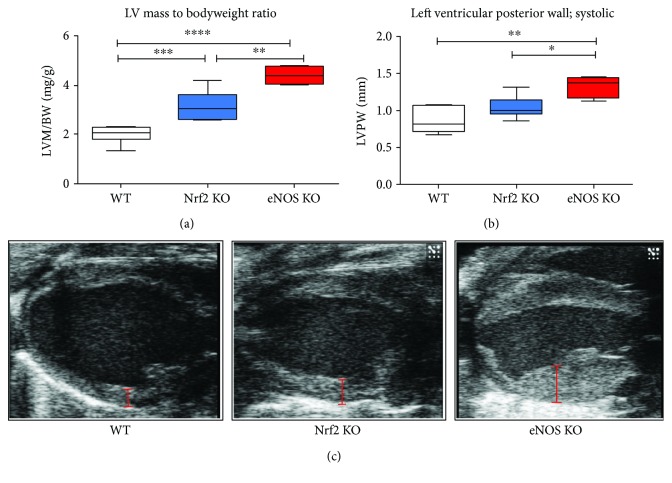
Cardiac hypertrophy in Nrf2 KO and eNOS KO mice. (a) LV mass normalized to body weight illustrates cardiac hypertrophy in both Nrf2 KO and eNOS KO mice as compared to WT mice. (b) Diameter of left ventricular posterior wall measured at the end of systole highlights the increase in myocardial hypertrophy in both KO mice. (c) Representative B-mode pictures of the heart from different mouse strains visualize the extent of cardiac hypertrophy. Red bars show the diameter of the left ventricular posterior wall. WT mice: n = 8, Nrf2 KO mice: n = 9, eNOS KO mice: n = 4; Browne-Forsythe test p > 0.05, means ± quartiles, one-way ANOVA ∗
p < 0.05, ∗∗
p < 0.01, ∗∗∗
p < 0.001, ∗∗∗∗
p < 0.0001.